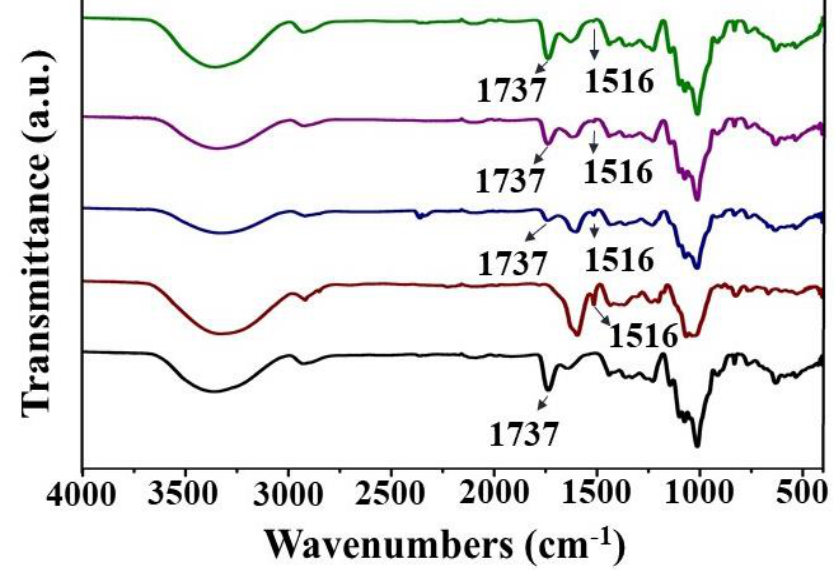
Fig. 4: FTIR spectra of pectin ( ▲ ), LS extract ( ▲ ), S8 ( ▲ ), S5 ( ▲ ), and S2 ( ▲ )